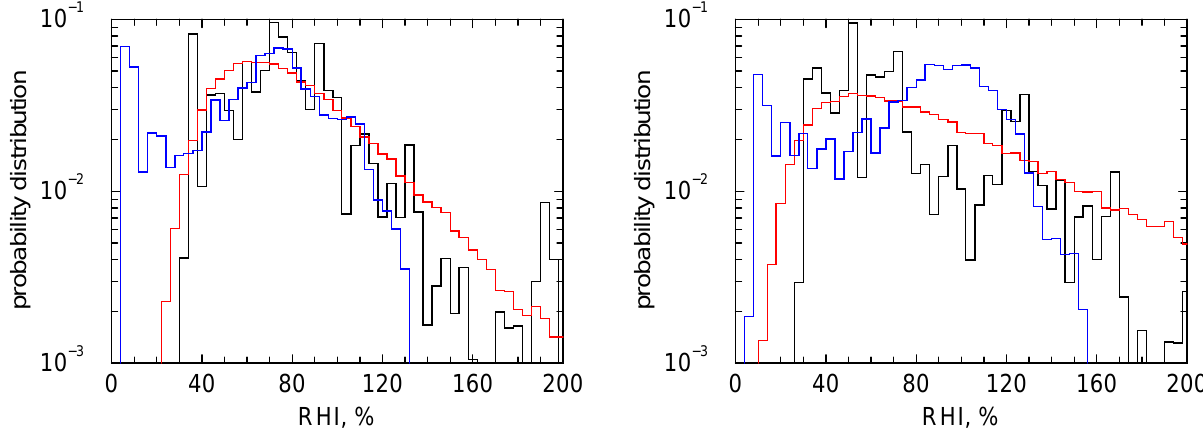
Fig. 7. Probability distributions of RHI (black curves) obtained with air temperatures measured during INCA (Prestwick, left panel; Punta Arenas, right panel). Red distributions are results from the statistical approach using Gaussian fits to the observed distributions of T with mean and standard deviation derived from the measurements (see Fig. 5), and observed mean relative humidities over ice (NH: 75%; SH: 85%) taken from Ovarlez et al. (2002). Blue distributions are generated directly from the INCA RHI data taken outside of cirrus clouds (Haag et al.,